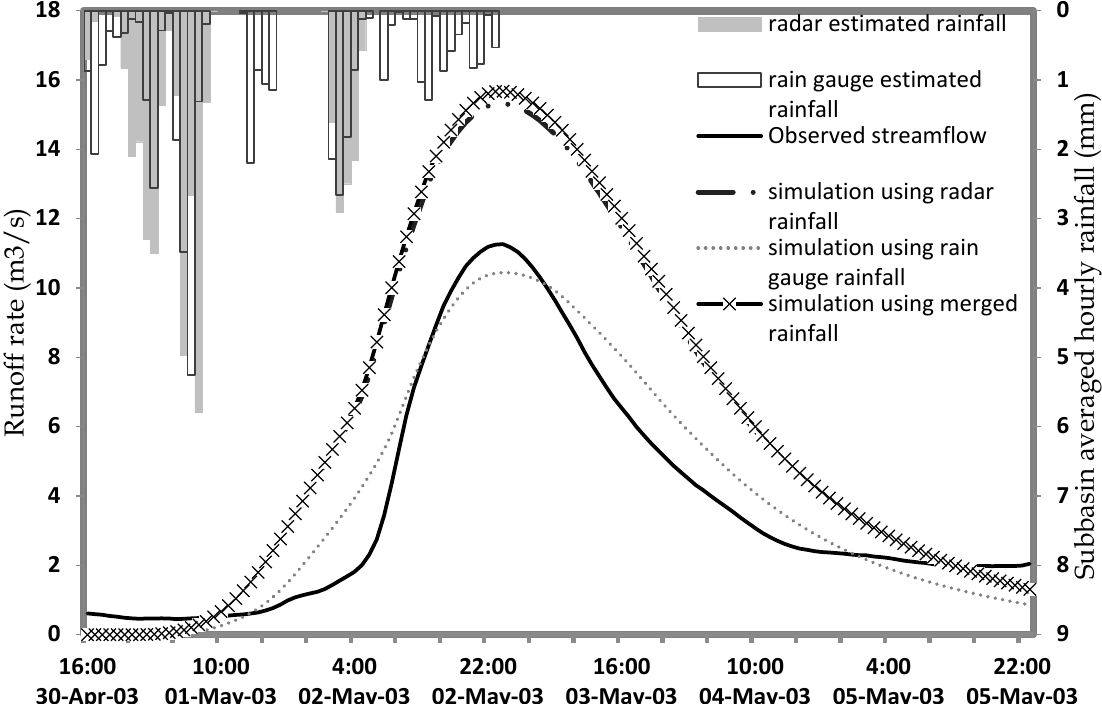
Figure 23. Comparison of estimated and observed hydrographs using different rainfall estimates for the 11 May 2002 event with Green and Ampt modeling option.